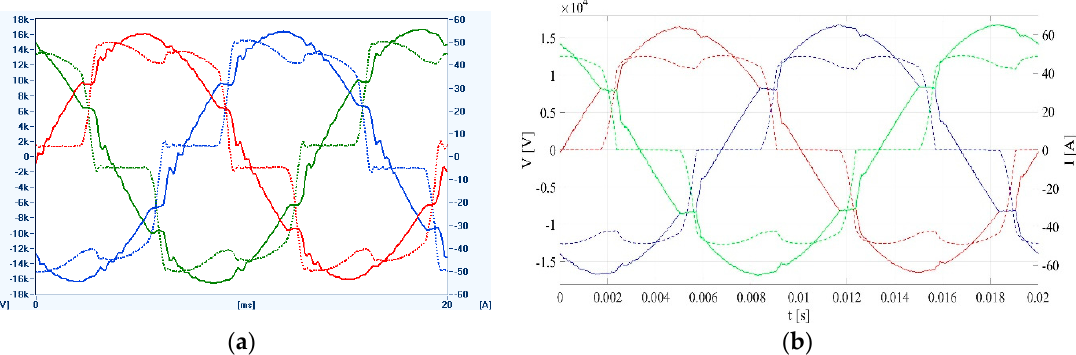
Figure 31. The voltages (full line) and the currents (chain line): ( a ) the measurement; ( b ) the simulation.